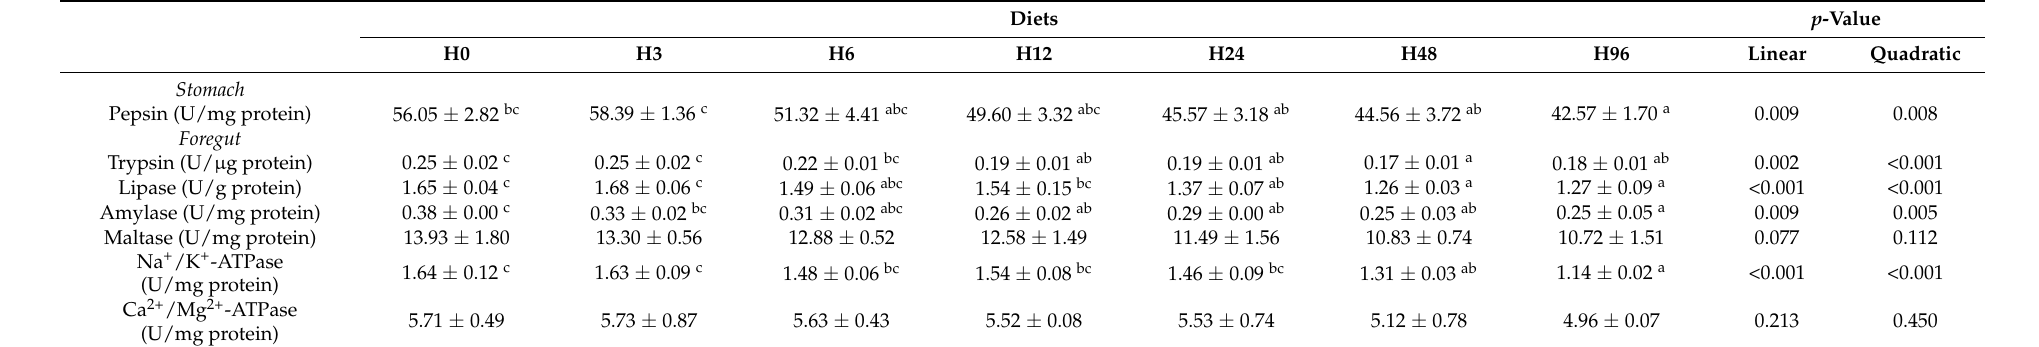
Table 4. Effect of dietary histamine content on the digestive enzyme activity in the gastrointestinal tract of the hybrid